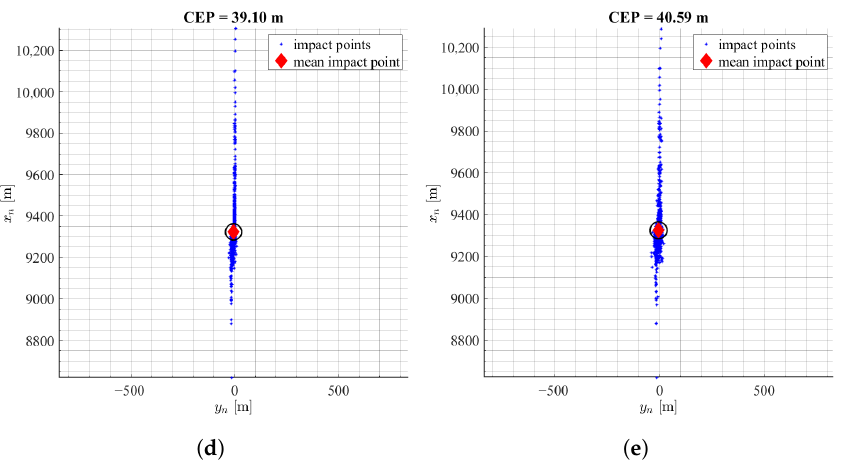
Figure 6. Results of landing point dispersion with uncertainties of aerodynamic data: ( a ) no control, ( b ) mPNG, ( c ) mPNG + IMU, ( d ) MCCA, ( e ) MCCA +